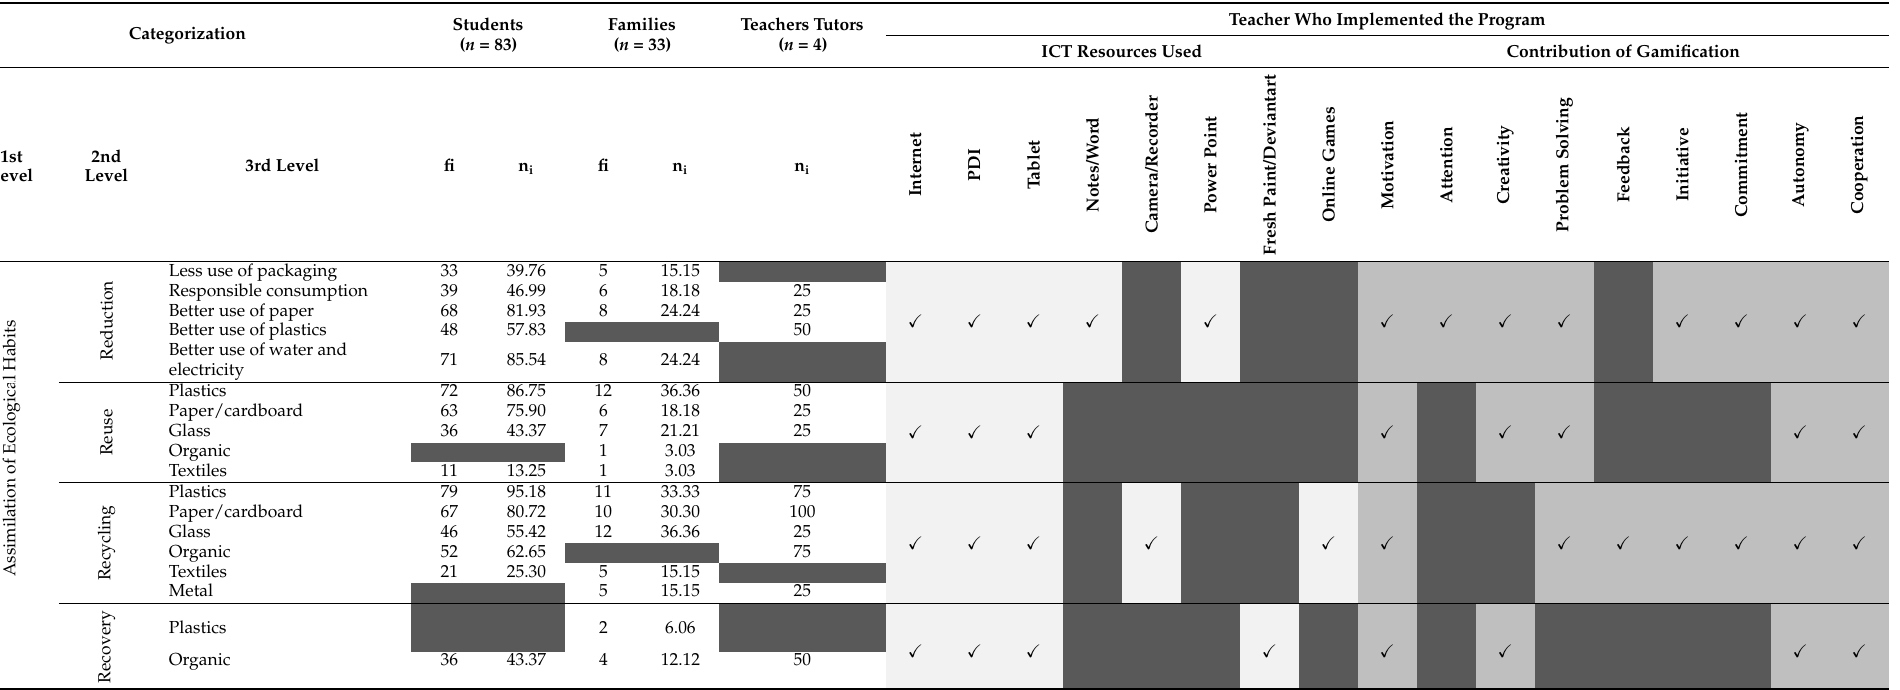
Table 4. Internalized ecological habits based on 4R